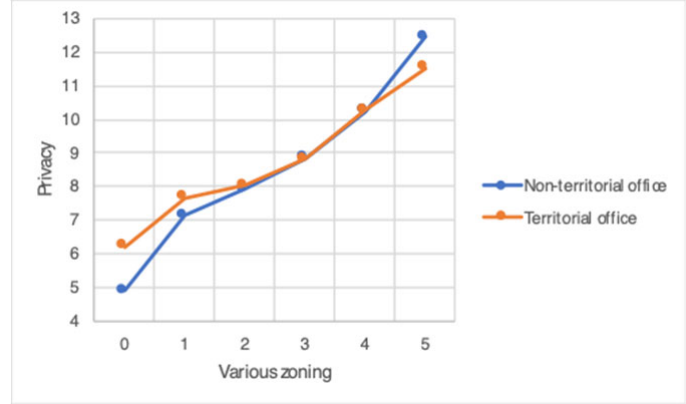
Figure 2. The relations among privacy, non-territorial office, and various